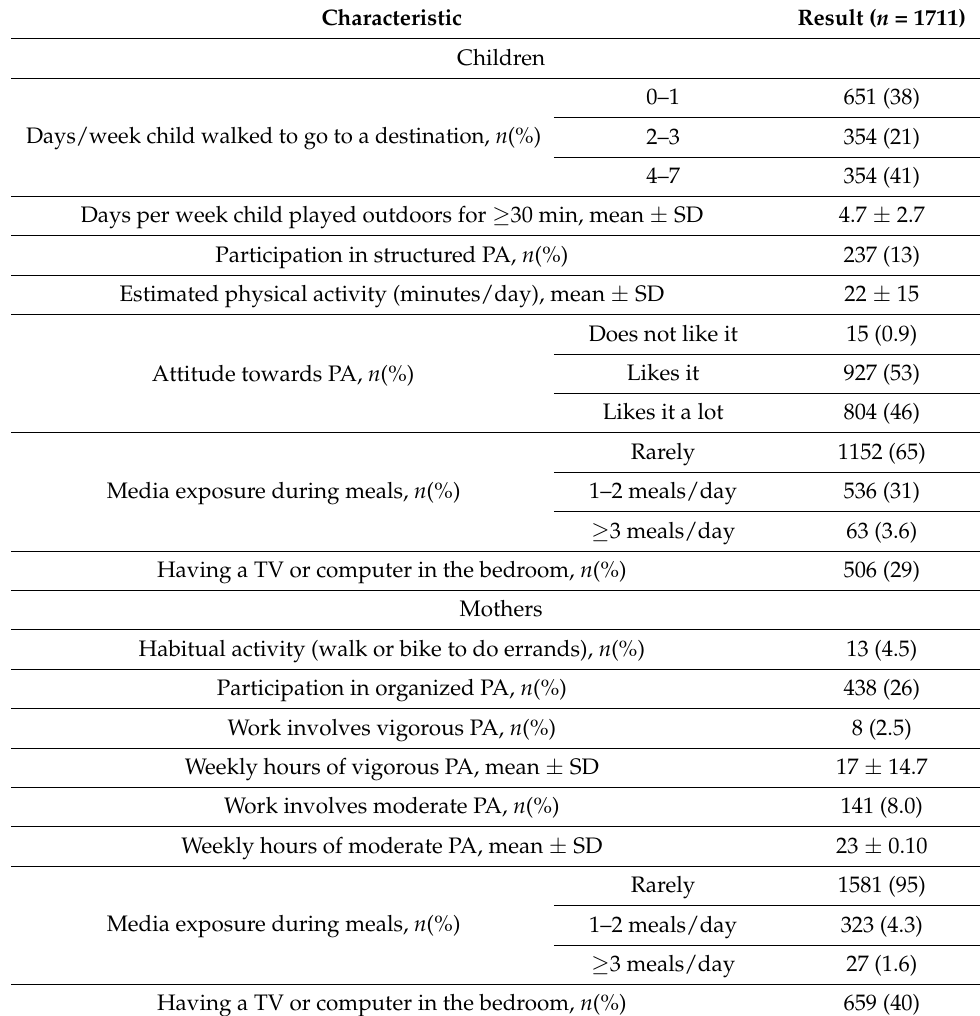
Table 2. Lifestyle characteristics of children and